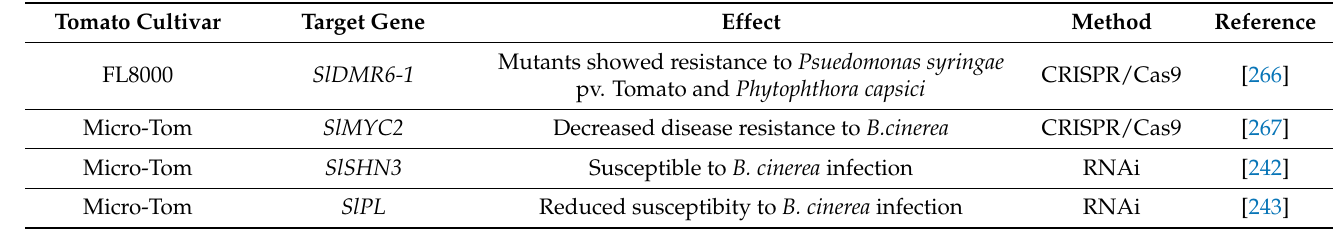
Table 1. Genome editing of tomato cultivars in response to biotic stress. APETALA2-domain transcription factor (SlSHN3), basic helix–loop–helix transcription factor (SlMYC2), Chitinase 1 gene from Helicoverpa armigera (HaCH1), coat protein (CP) or replicase (Rep) of TYLCV, Dicer-like (DCL1), DNA binding protein from starved cells of Ralstonia solanacearum (RsDps), Downy mildew resistance 6-1 (SlDMR6-1), early TYLCV replication associated protein gene (C1), Fusarium MAP kinase (Fmk1), High osmolarity glycerol pathway genes (Hog1 and Pbs2 ), hairpin RNA (hpRNA) construct derived from Potato spindle tuber viroid (PSTVd), JASMONATE ZIM DOMAIN2 (SlJAZ2), MAP kinase3 (SlMAPK3), MILDEW RESISTANT LOCUS O1 (SlMLO1), nucleotide-binding site (NBS) and leucine-rich repeat (LRR) gene (SlNL33), one of the disrupted genes